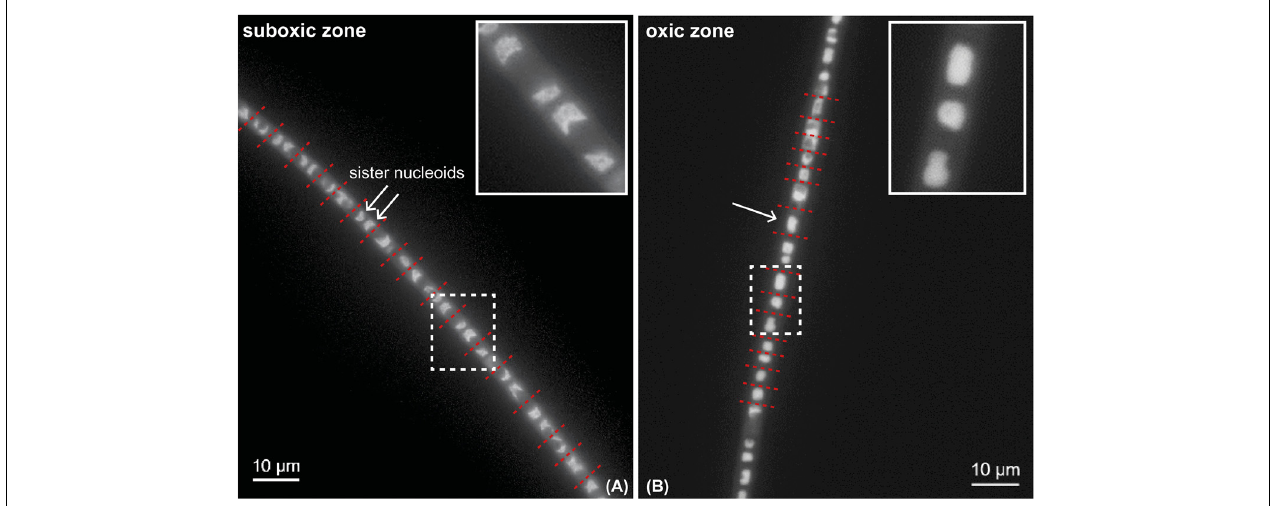
FIGURE 5 | DAPI-stained fluorescence microscopy image of a cable bacterium filament. DAPI stains the DNA inside the cells. White arrows mark individual nucleoids. Red dotted lines show the position of the cell septa. Insets show a close-up of areas indicated by white dotted rectangles. Segments from the same filament are shown, but residing in the oxic and suboxic zones. (A) Cells in the suboxic zone show two separated chromosomes in a crescent-shape at each of the cell poles. (B) Cells in the oxic zone show a single condensed chromosome that occupies a large part of the cell